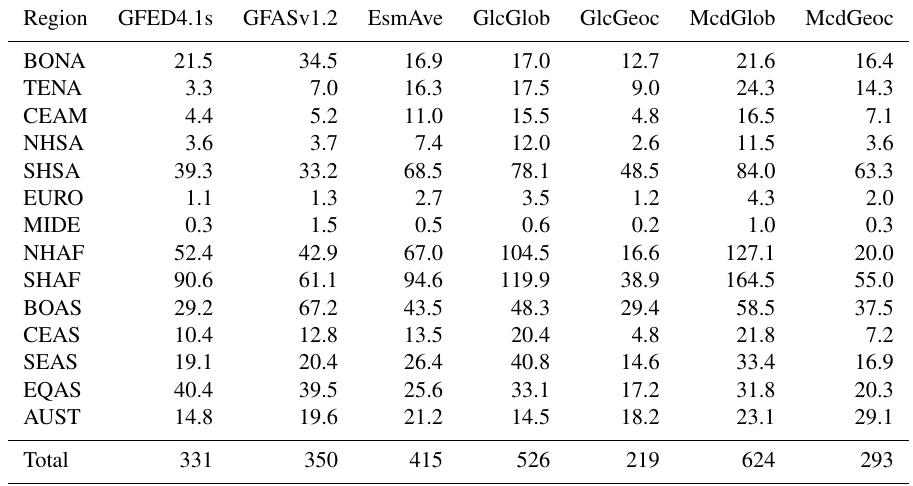
Table 4. Mean annual BB CO emissions (Tgyr − 1 ) from the GFED4.1s, GFASv1.2, and this study’s estimates over the 14 global regions (see Fig. A1) between 2009 and